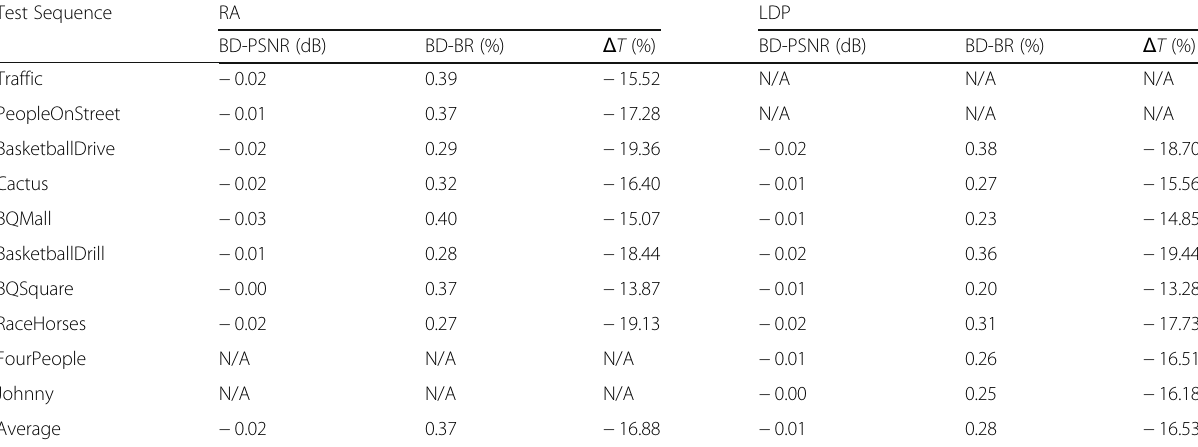
Table 9 Comparison between SRA and the original HM 14.0